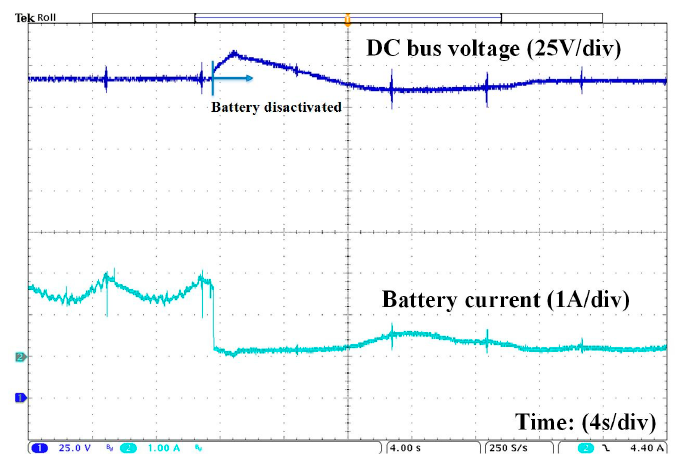
Figure 34. End of the power supply to the BB.